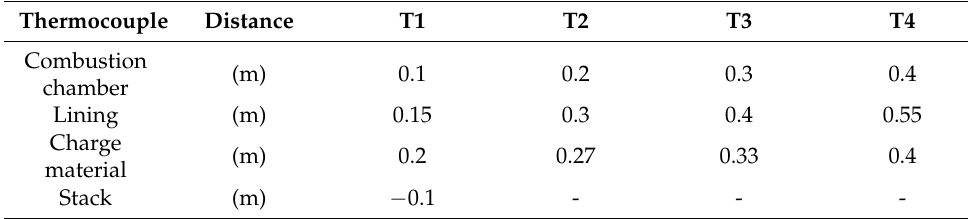
Figure 2. Distribution of thermocouples in the furnace (blue) lining, (green) combustion chamber, (red) charge material, (black) stack. Table 1. Distances of individual thermocouples from the burner.